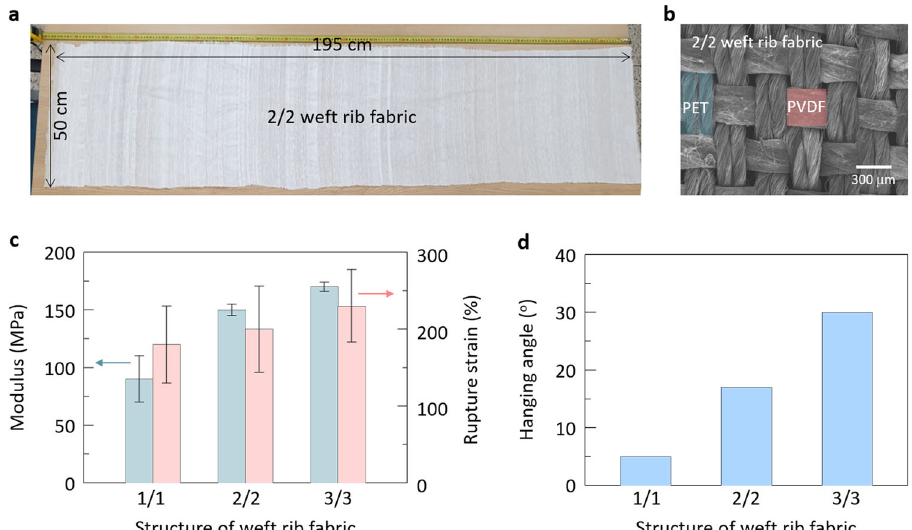
Fig. 2 Large-area fabric and their physical characteristics. a Photograph of the large-scale woven fabric with the 2/2 weft rib pattern, reaching dimensions of 195 cm × 50 cm. b SEM image of the 2/2 weft rib pattern consisting of alternately crossing a single strand of PVDF weft yarn with two strands of PET warp yarn. c Modulus and rupture strain of different woven fabrics of 1/1, 2/2, and 3/3 weft rib patterns. d Hanging angles measured for the